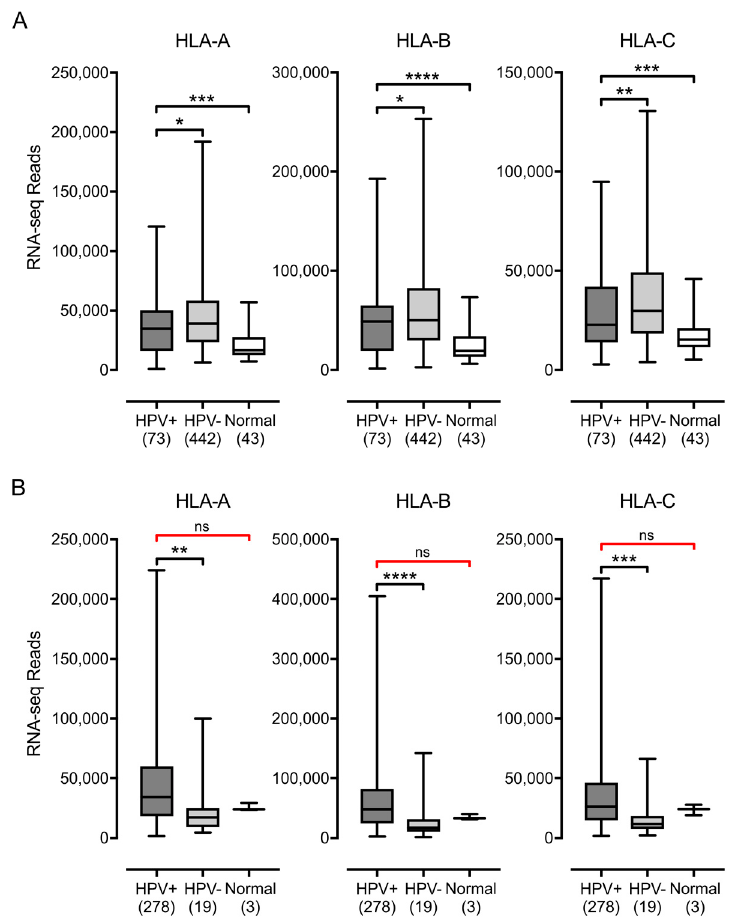
Figure 1. Expression of classical major histocompatibility complex class I (MHC-I) heavy chain genes in head & neck or cervical carcinomas stratified by human papillomavirus (HPV) status. Normalized RNA-seq data for the indicated MHC-I heavy chain genes was extracted from The Cancer Genome Atlas (TCGA) database for the head & neck cancer (HNSC) ( A ) and cervical carcinoma (CESC) ( B ) cohorts for HPV+, HPV − , and normal control tissues. Numbers in brackets refer to the number of samples included in each analysis. * p ≤ 0.05; ** p ≤ 0.01; *** p ≤ 0.001; **** p ≤ 0.0001; ns—not significant; red brackets indicate a comparison that did not achieve significance with a power value <0.8.